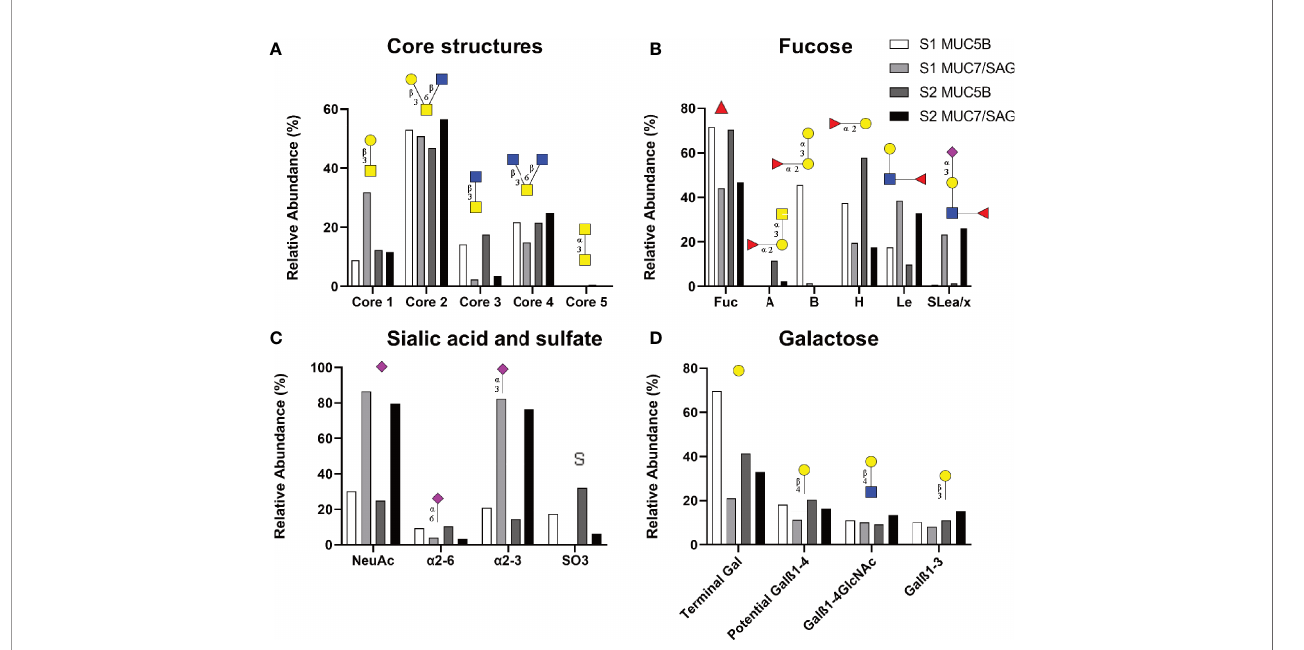
FIGURE 3 | Relative abundance of glycans on salivary mucins analyzed by LC-MS summarizing core (A) , fucose (B) , Sialic acid and sulfate (C) and galactose containing structures. The datasets contain the relative abundances of the glycans in MUC5B rich and MUC7/SAG rich samples from each individual (Sample 1: S1; blood group B, Sample 2: S2; blood group A). Symbol Nomenclature for Glycans: ( ) = Fuc, ( ) = Gal, ( ) = GlcNAc, ( ) = GalNAc and ( ) =